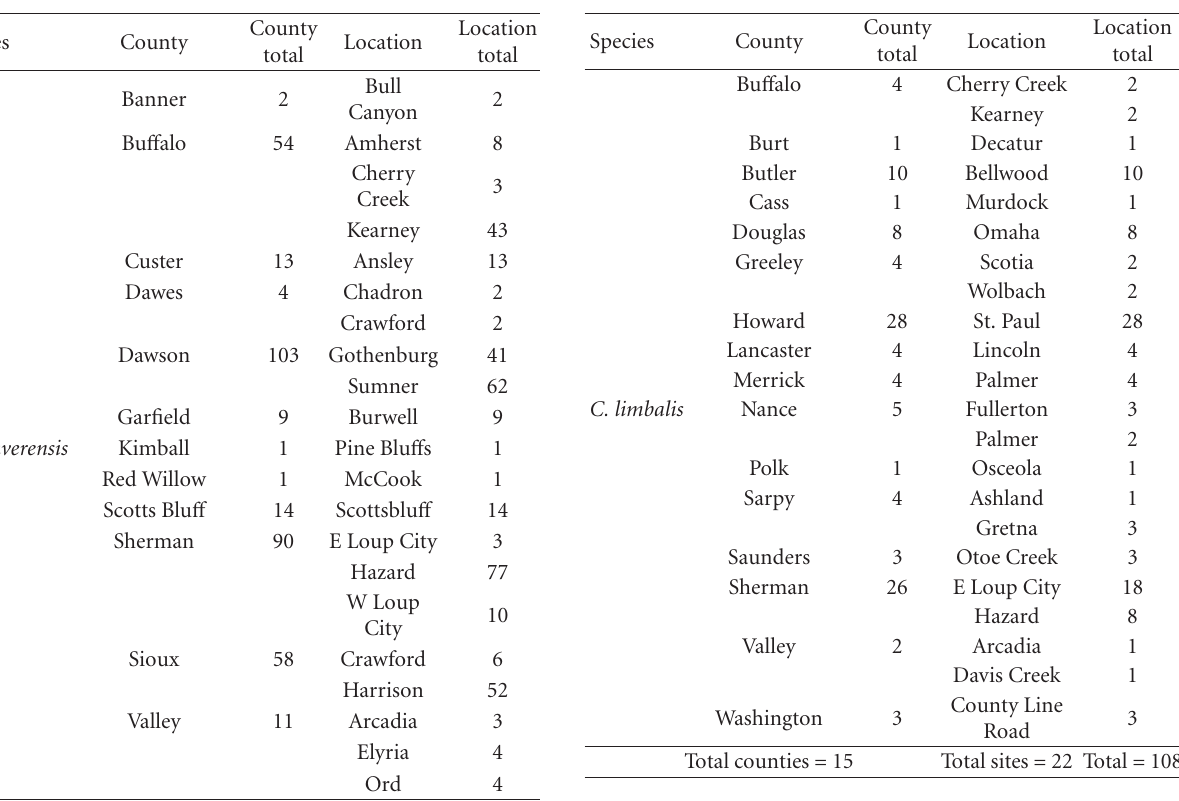
Table 3: Locality information for specimens of C. limbalis exam-